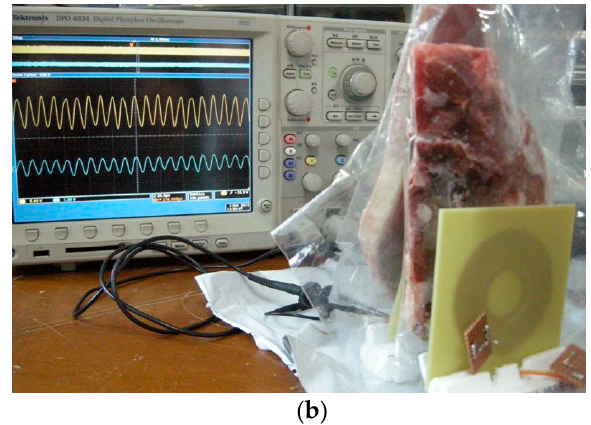
Figure 22. Experimental setup of the PTE measurement in the beef muscle tissue medium. ( a ) Square coil; ( b ) Circular coil.